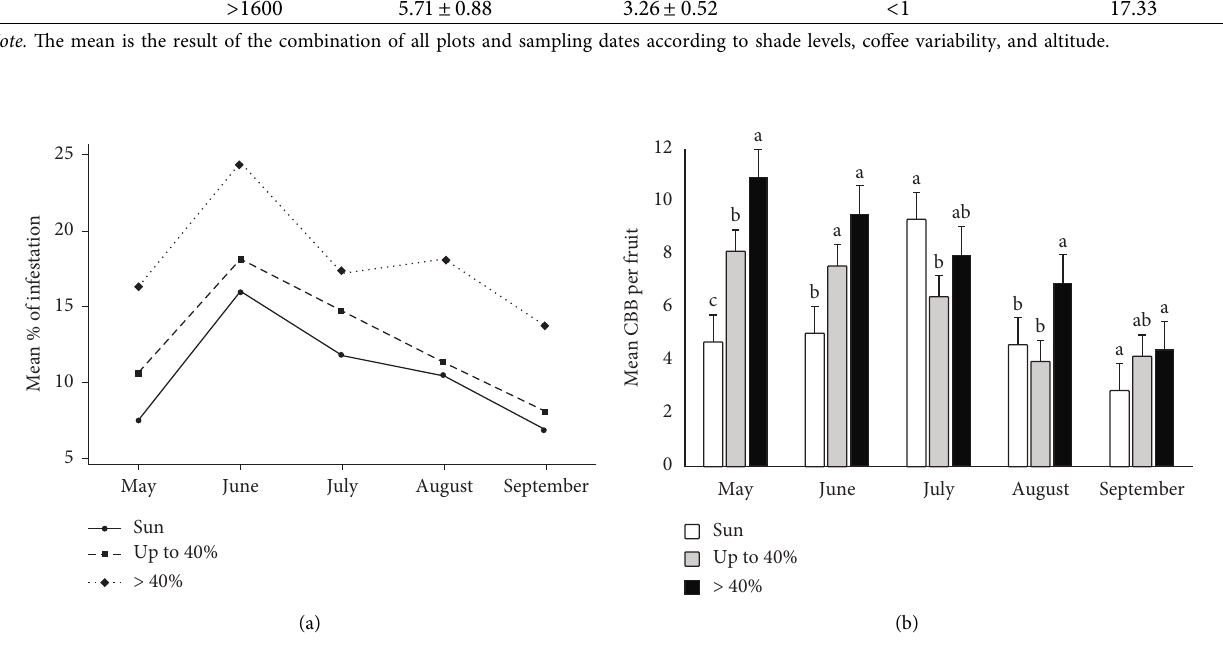
Figure 1: Monthly changes in (a) infestation and (b) CBB per fruit according to shade levels. Te letters above bars indicate statistical diferences between CBB per fruit means (means separations test are independent for each month).